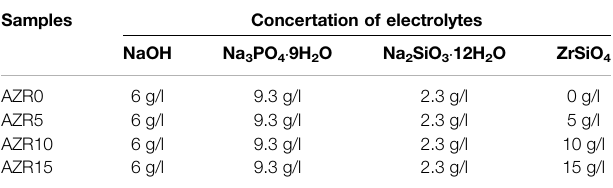
TABLE 1 | Composition of electrolyte.